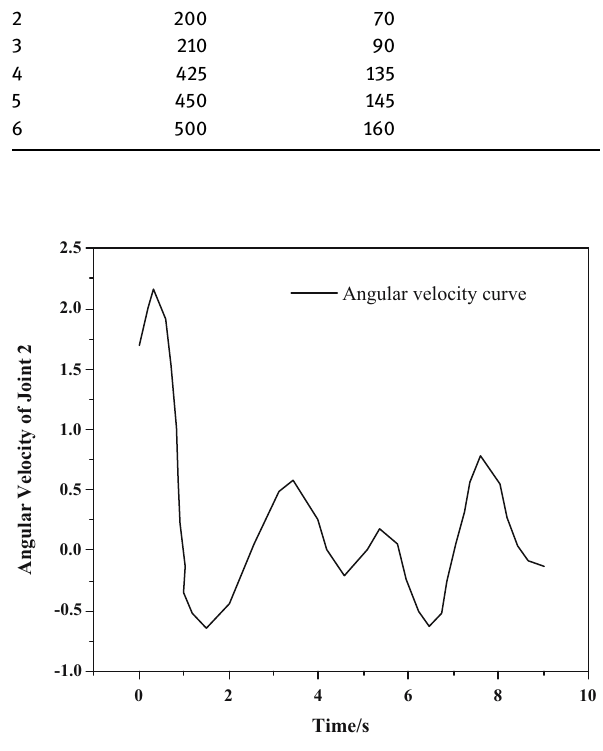
Figure 2: Angular velocity curve of joint 2 of cubic B - spline programming.